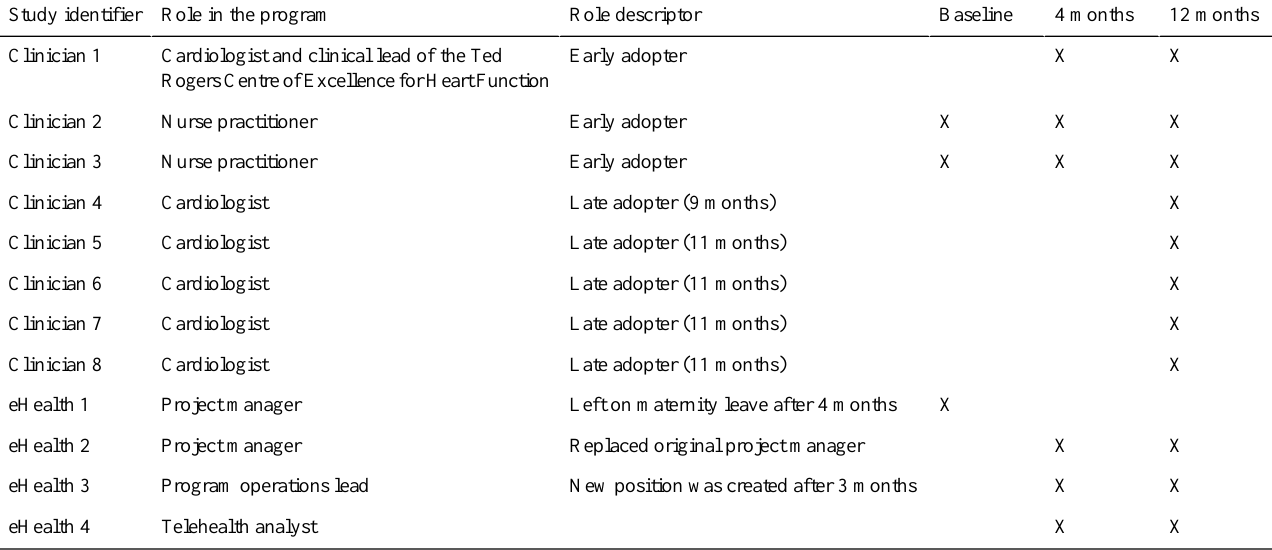
Table 1. Study participants and timing of interviews. An "X" incicates an interview was conducted at the specified time point.